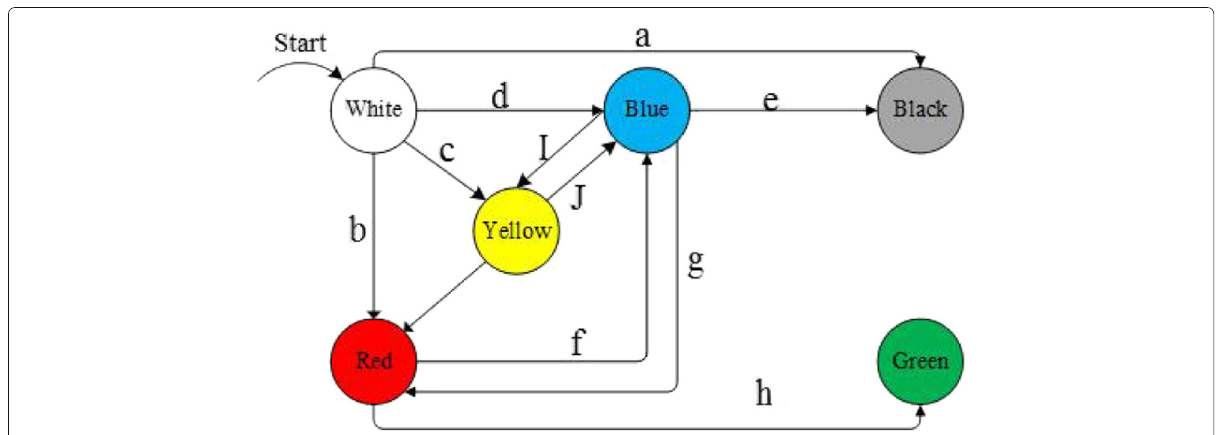
Fig. 1 Sensor state transition of our algorithm. The transition conditions are as follows: a has the largest value of | N 2 ( v ) | | has a red neighbor but does not have black neighbor; d exists a yellow neighbor but does not have black or red neighbor; e has the largest value of | N 2 ( v ) | 2 ( v ) and N ( v ) only contain white nodes; f becomes connector; g exists a black neighbor; h has the maximum | N ( v ) | among all blue nodes, where N number of yellow neighbors among all red nodes; I has a red neighbor but does not have black neighbor; J becomes connector